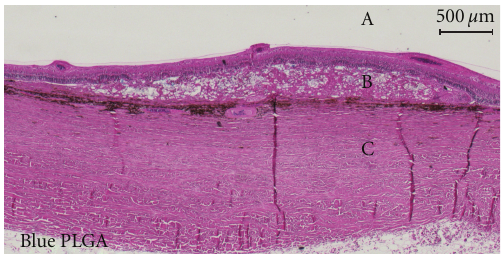
Table 1: Distribution of complications after subretinal transplanta- tion of white and blue PLGA membranes. Membrane Membrane Reaction in the implanted dislocated to the vitreous body outside visual vitreous body streak White PLGA 2 3 1 Blue PLGA 2 1 1 Figure 3: Micrograph of Hematoxylin- and Eosin-stained porcine retina after subretinally transplanting white PLGA membrane (B). The membrane is degrading in a spongiform manner disrupting and partly destroying the outer retina with no preserved photore- ceptor segments and a flattened, disrupted, or completely missing outer nuclear layer. The inner nuclear layer is relatively intact and there is no sign of severe inflammation in either retina or choroid. Retina adjacent to the membrane appears intact. Vitreous body is indicated by “A” and sclera by “C”.